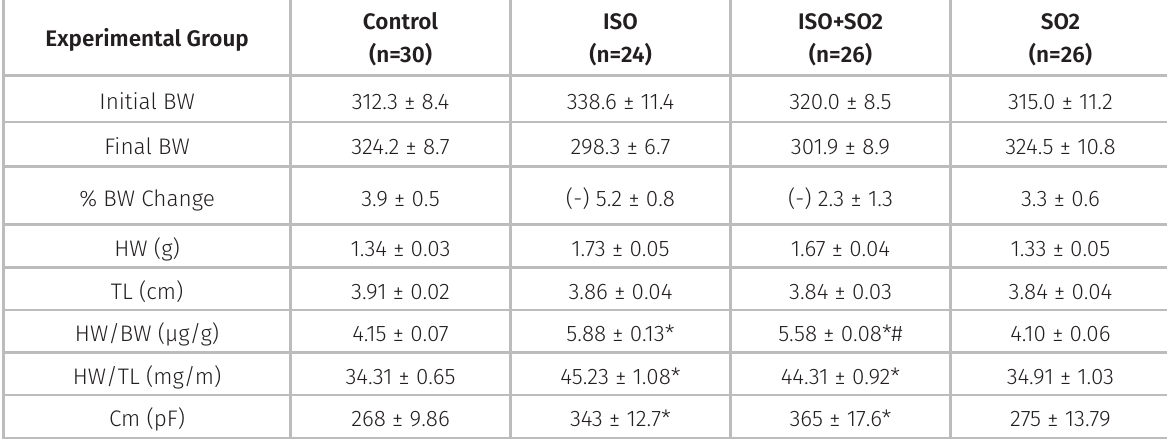
Values are means ± SEM. *p< 0.01 versus Control animals; #p< 0.01 versus ISO animals. HW: Heart Weight, BW: Body Weight, TL: Tibia Length. Cm:Cell membrane